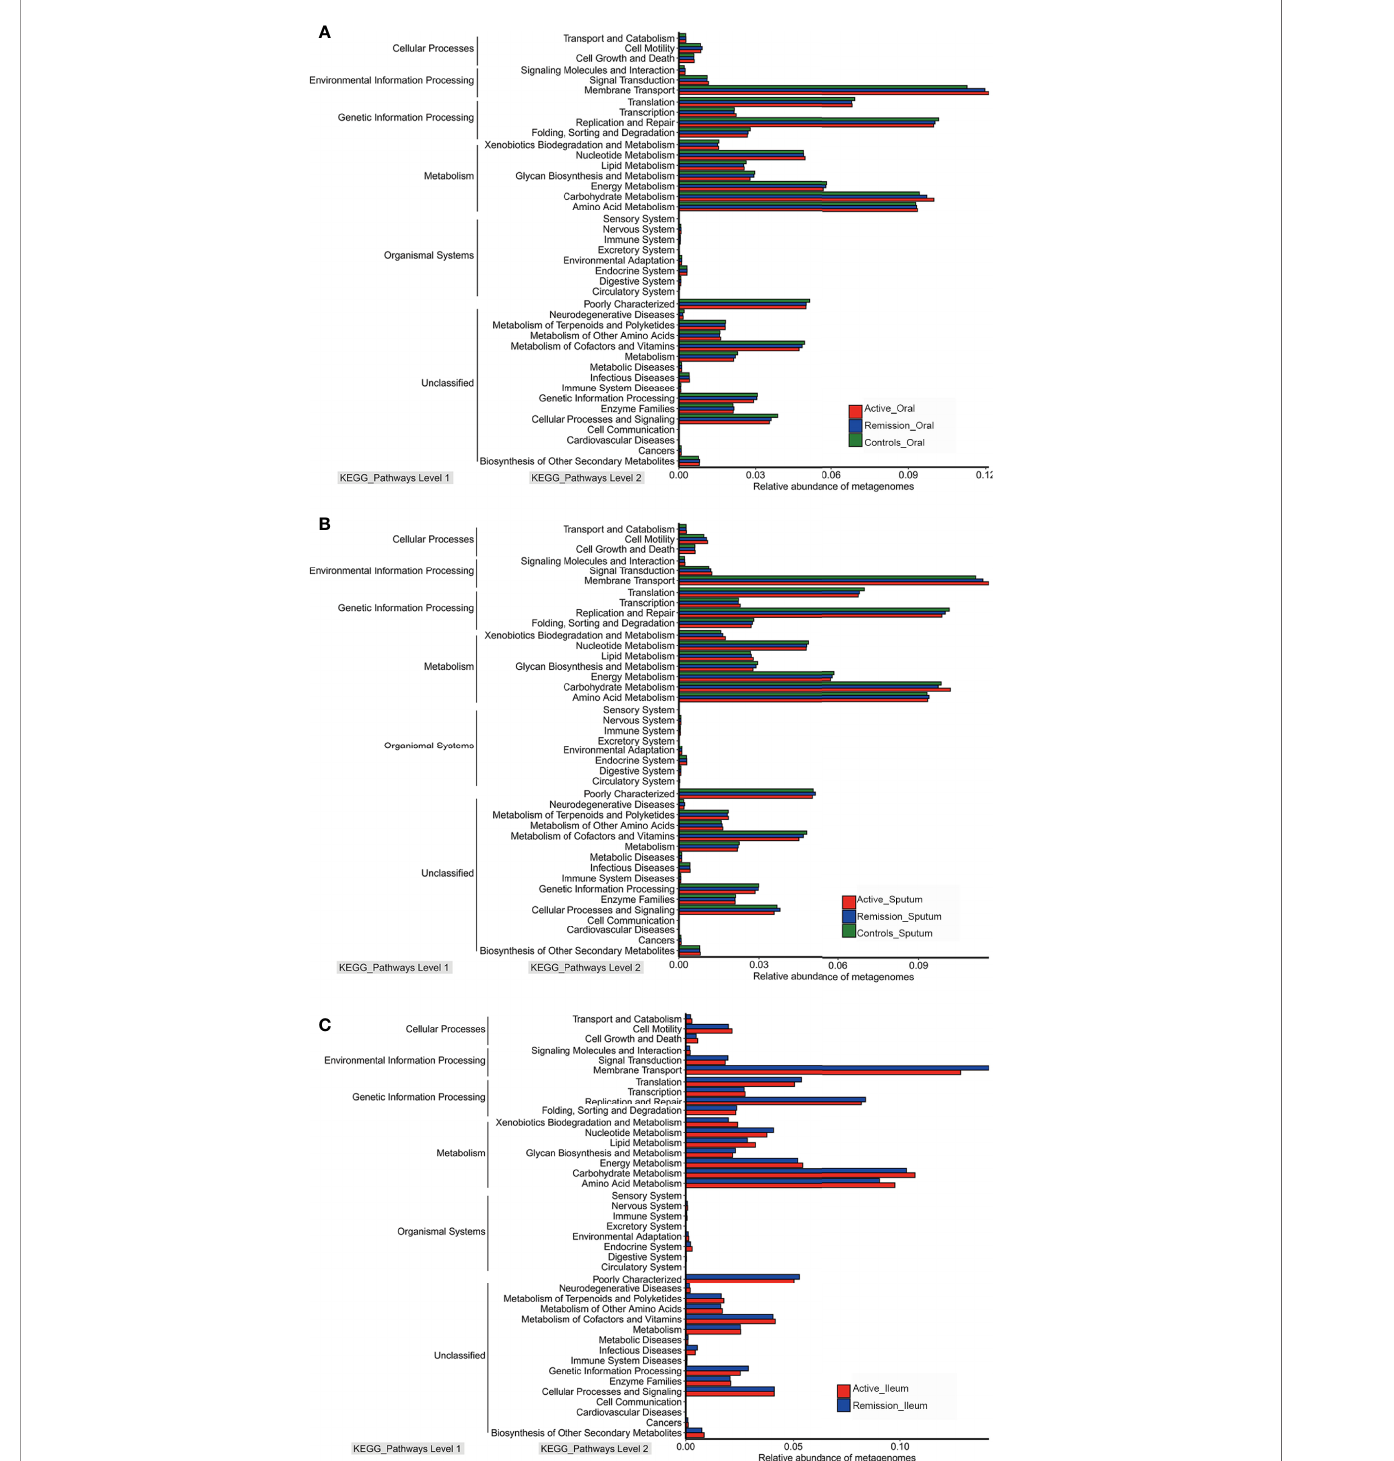
FIGURE 8 | Relative abundances of metagenomes of different KEGG pathways level in microbiota of patients with CD. (A) Relative abundances of metagenomes of different KEGG pathways level in oral microbiota of patients with CD. (B) Relative abundances of metagenomes of different KEGG pathways level in sputum microbiota of patients with CD. (C) Relative abundances of metagenomes of different KEGG pathways level in ileal microbiota of patients with CD. Red color represents samples from active stage, blue indicates remission stage, while green color indicates healthy controls,